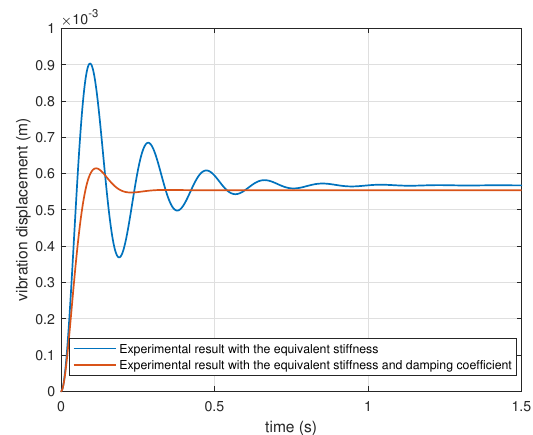
Figure 5. The experimental physical photo.